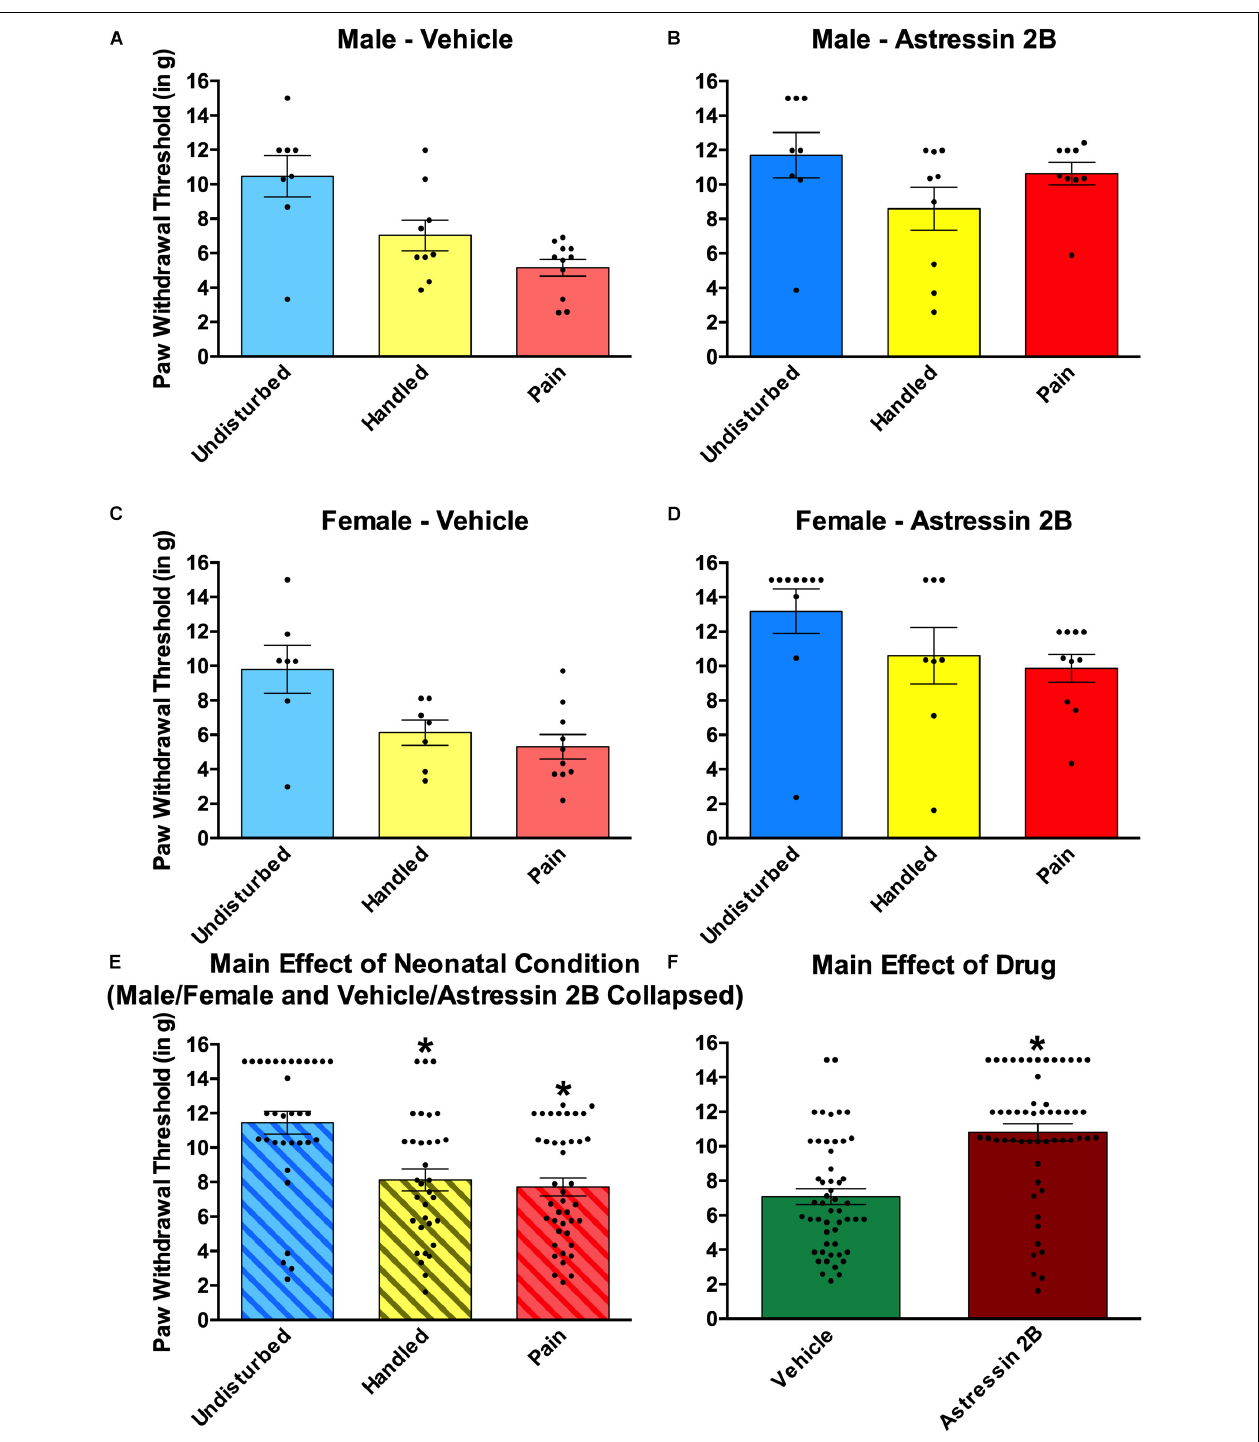
FIGURE 8 | Effects of Astressin 2B on paw withdrawal thresholds on the von Frey mechanical allodynia measure in neonatally manipulated rats for Experiment 2. (A) Male vehicle-treated rats (Undisturbed—N = 8, Handled—N = 9, Pain—N = 11), (B) male Astressin 2B-treated rats (Undisturbed—N = 8, Handled—N = 9, Pain—N = 9), (C) female vehicle-treated rats (Undisturbed—N = 7, Handled—N = 7, Pain—N = 10), and (D) female Astressin 2B-treated rats (Undisturbed—N = 10, Handled—N = 8, Pain—N = 10). The bottom two panels depict (E) the same data collapsed across sex and drug to show the main effect of neonatal condition and (F) with the same data collapsed across sex and condition to show the main effect of drug. These data indicated that neonatal manipulation creates a tactile hypersensitivity in both male and female rats and that there is a general antinociceptive effect following CRF 2 antagonism via Astressin 2B into the CeA. Data are presented as means with error bars as ± SEM; *denotes significant ( p < 0.05) difference between indicated groups.